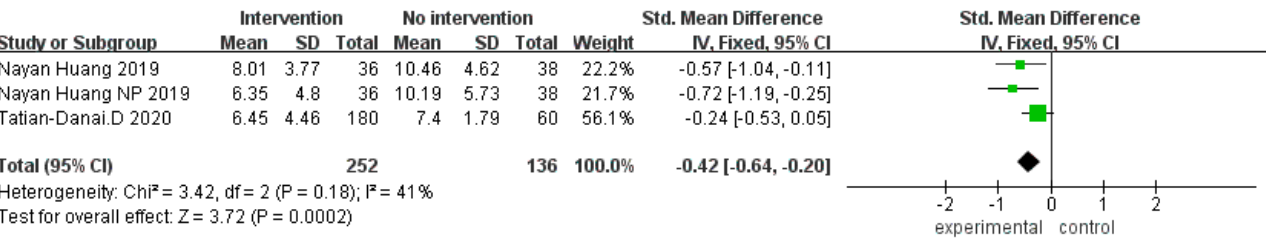
Figure 5. Forest plot of Neuropsychiatric Questionnaire scale for neuropsychiatric function improvement [32,36].